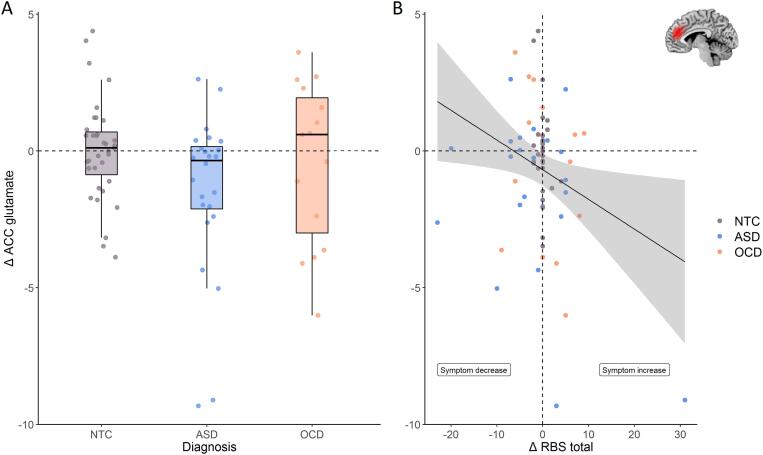
ACC glutamate. A: Glutamate concentrations, shown in institutional units (i.u.), decreased over time in the ASD (N = 24) group (blue) compared with controls (N = 35) (grey). Plot was created using ggplot2 (Ginestet, 2011) and in-house adapted violin plots (Hintze and Nelson, 1998). * p < 0.05. B: Effects of changes of changes in RBS-R total score on changes in ACC glutamate (in i.u.). The linear regression line shows a negative association of Δ RBS-R total score with changes Δ ACC glutamate, independent of diagnosis. The shaded area represents the 95% confidence interval. Dots on the vertical dashed line represent participants that did not change in RBS-R total scores. Note: this figure shows raw data-points, not model estimates. (For interpretation of the references to colour in this figure legend, the reader is referred to the web version of this article.)